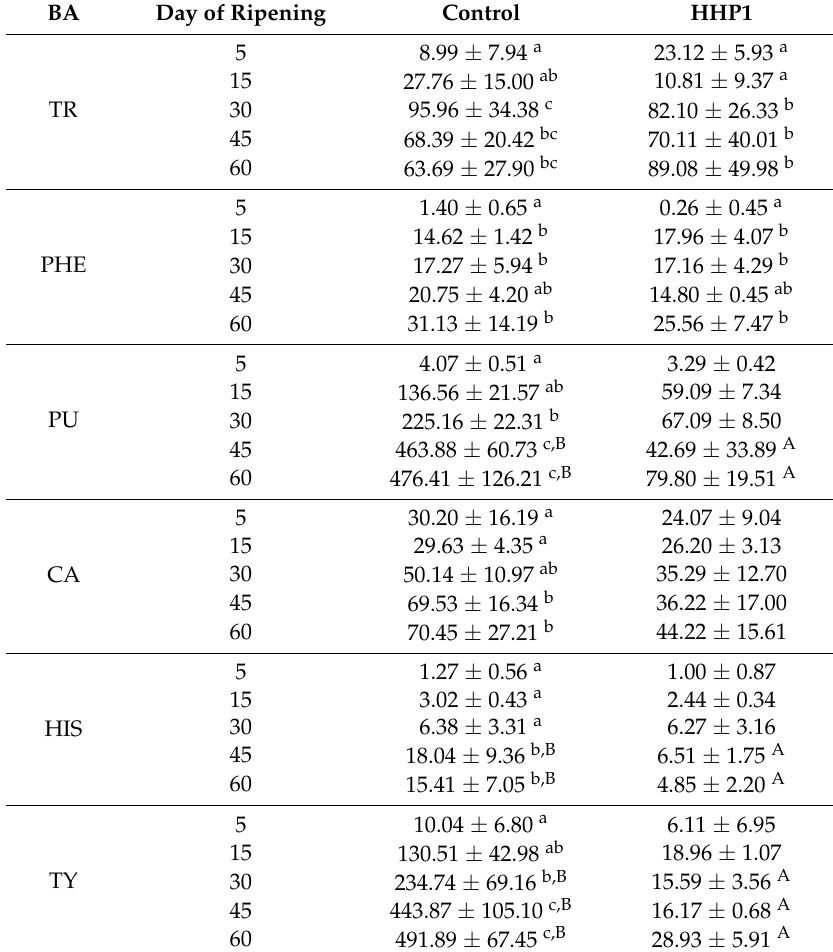
Table 5. Monoamine and diamines content (mean values ± standard deviation expressed as mg/kg in dry basis) formed during the ripening of goats’ raw milk cheese samples with and without HHP treatment.